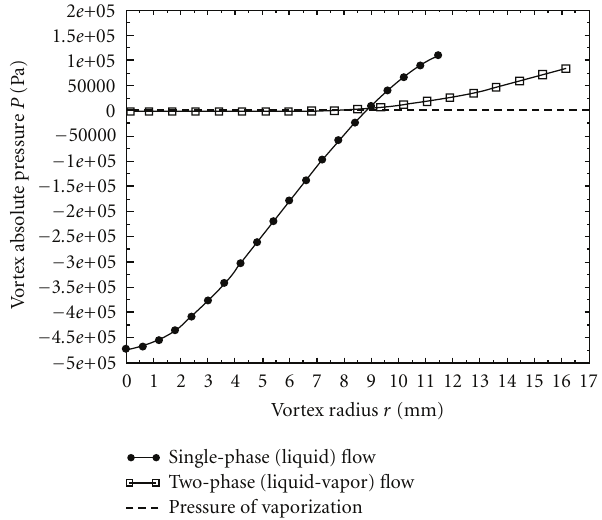
Figure 9: Radial pressure distribution inside the main vortex V1, computed for liquid flow (filled circles, see Figure 7) and liquid- vapor flow (squares).